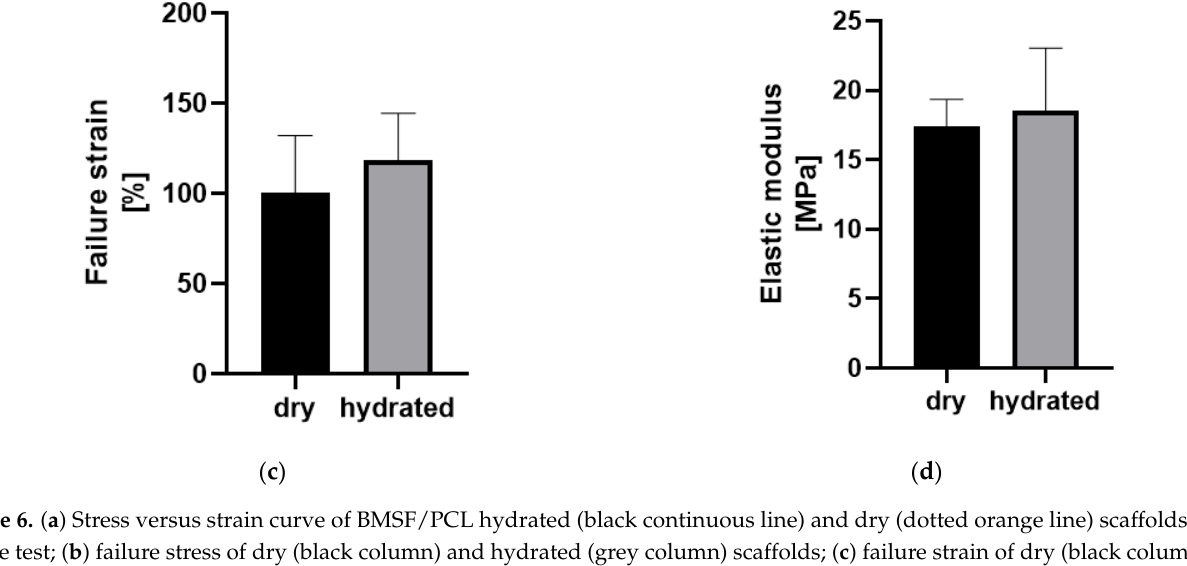
Figure 6. ( a ) Stress versus strain curve of BMSF/PCL hydrated (black continuous line) and dry (dotted orange line) scaf- folds under tensile test; ( b ) failure stress of dry (black column) and hydrated (grey column) scaffolds; ( c ) failure strain of dry (black column) and hydrated (grey column) scaffolds; ( d ) elastic modulus (E) of dry (black column) and hydrated (grey column) scaffolds.